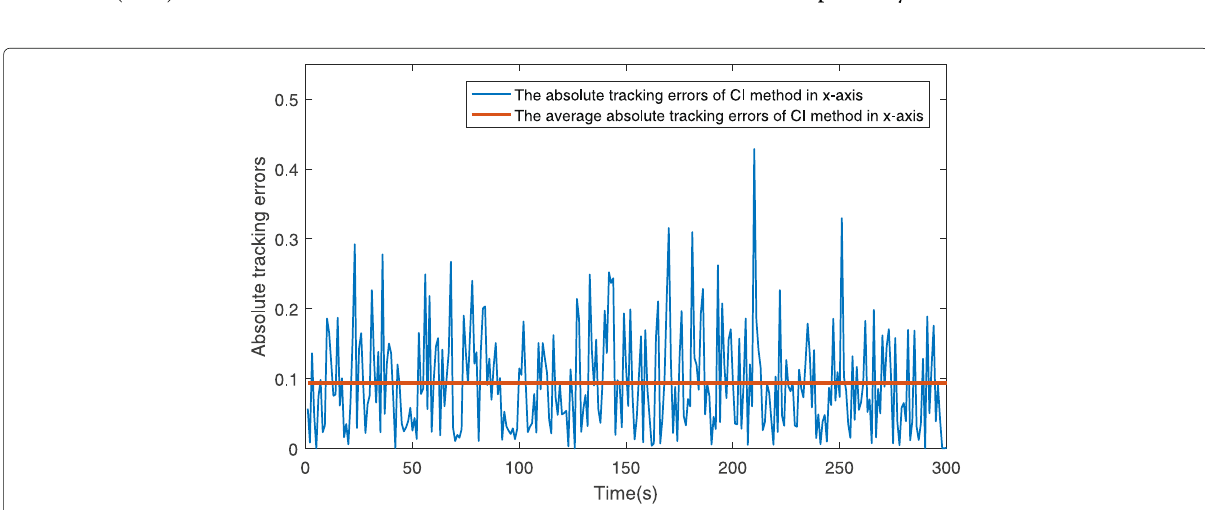
Fig. 1 The absolute tracking errors of CI method in x -axis with a i =